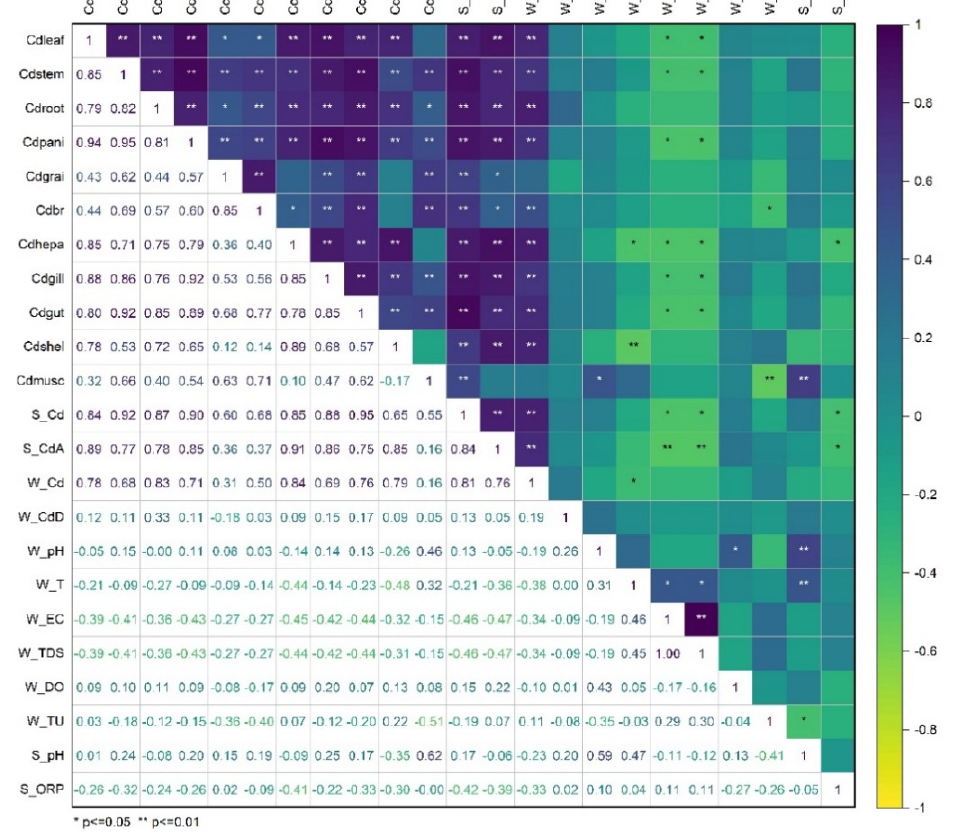
Figure 6. The relationship between Cd distribution in rice tissues and crayfish organs and environmental factors. The Cd leaf , Cd stem , Cd root , Cd pani , Cd grai , and Cd br represent Cd concentration in leaf, stem, root, panicle, grain, and brown rice of rice. The Cd hepa , Cd gill , Cd gut , Cd shel , and Cd musc represent Cd concentration in hepatopancreas, gill, gut, exoskeleton, and abdominal muscle of crayfish. S and W represent soil and water, respectively. Cd A and Cd D represent available Cd and dissolved Cd, respectively.